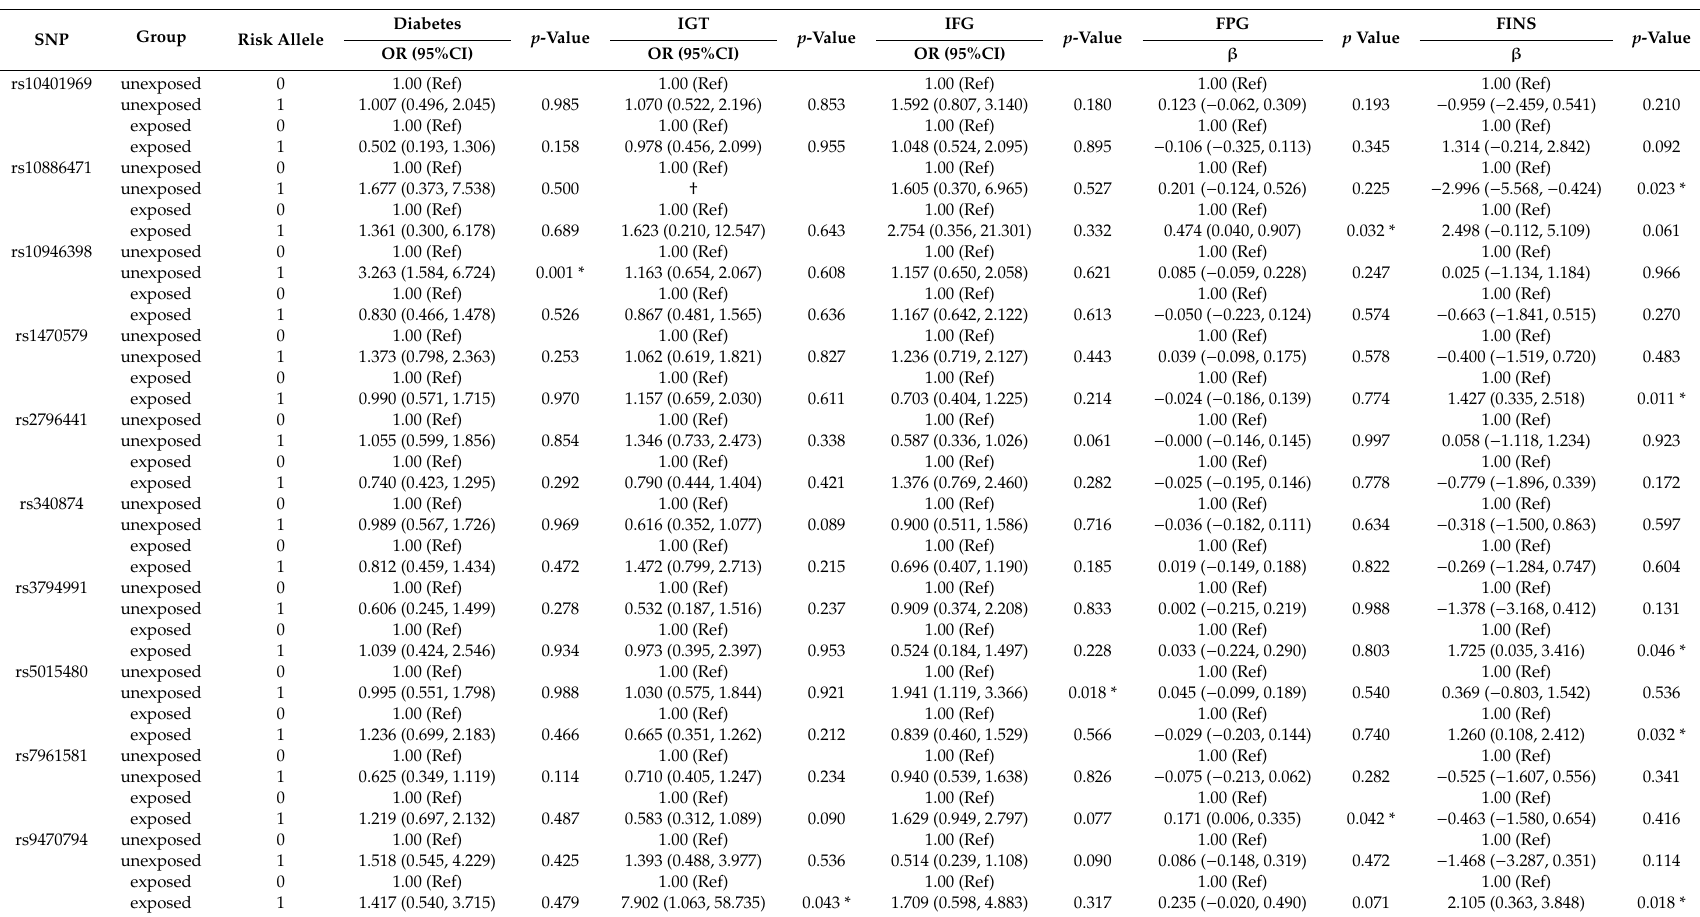
Table 3. Associations between SNPs and diabetes risk according to prenatal exposure to